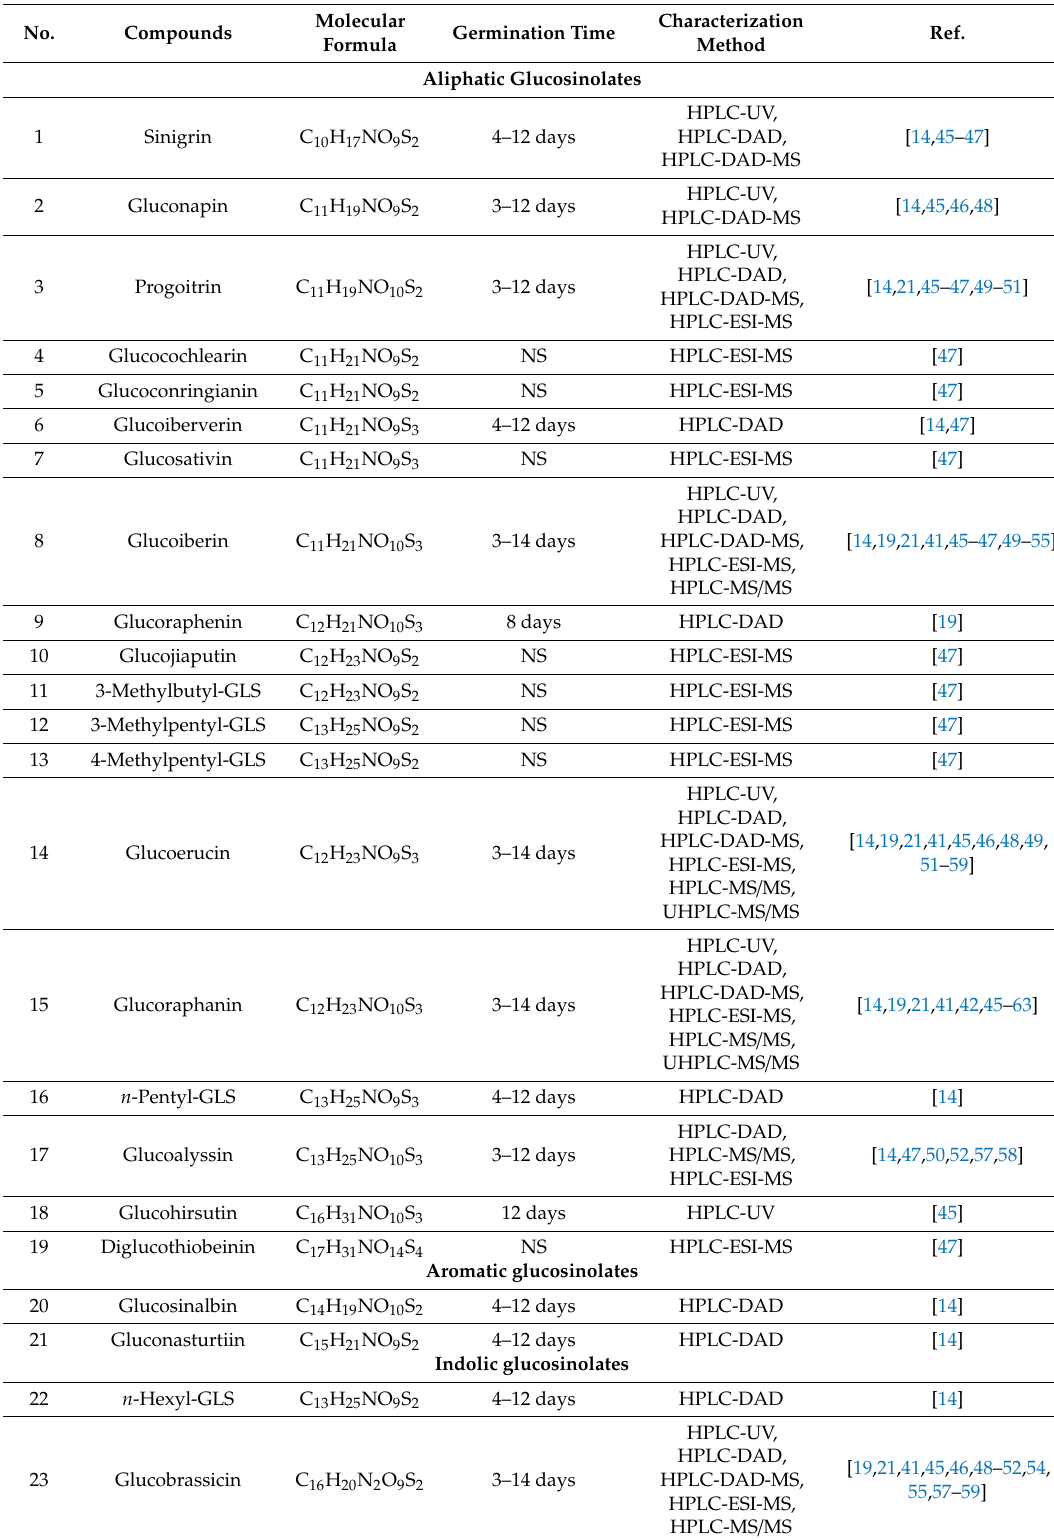
Table 1. Analysis of glucosinolates in broccoli sprouts and